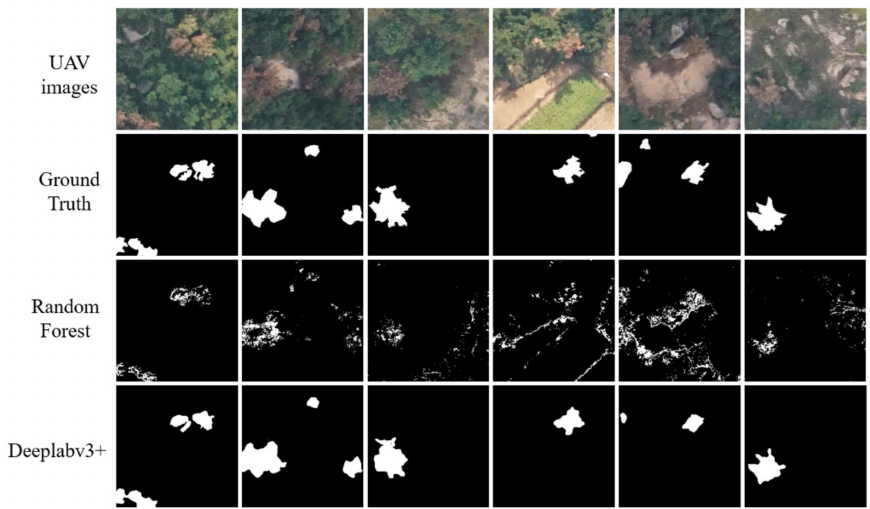
Figure 7. Comparison between the best DL model, Deeplabv3+, and the traditional machine learning method